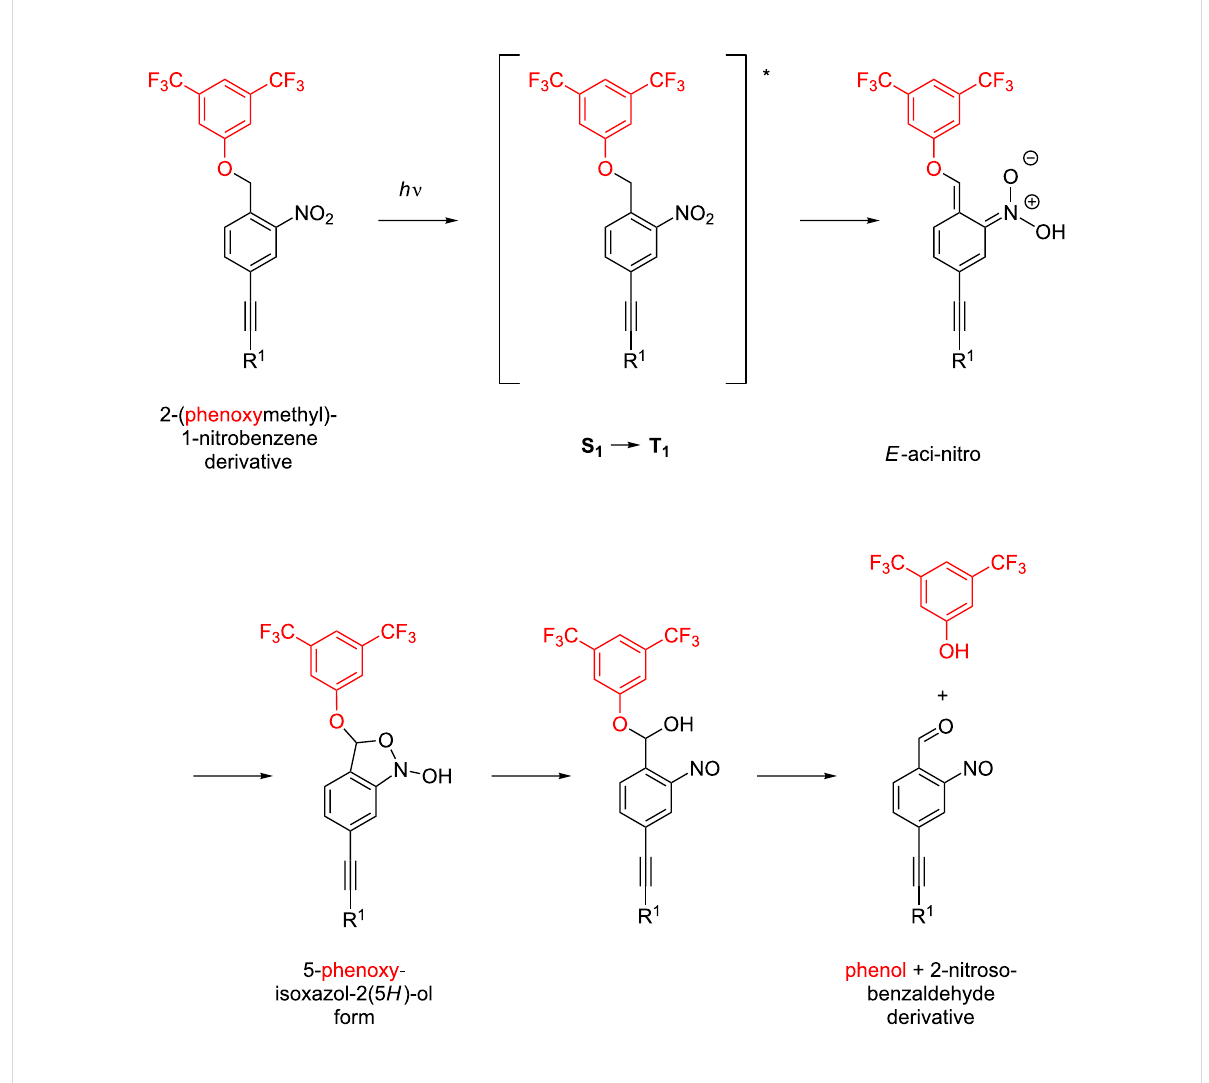
Figure 1: Sketch of the photocleavable 2-(phenoxymethyl)-1-nitrobenzene subunit and its intramolecular photon induced degradation sequence which leads to the release of the phenol subunit (red).